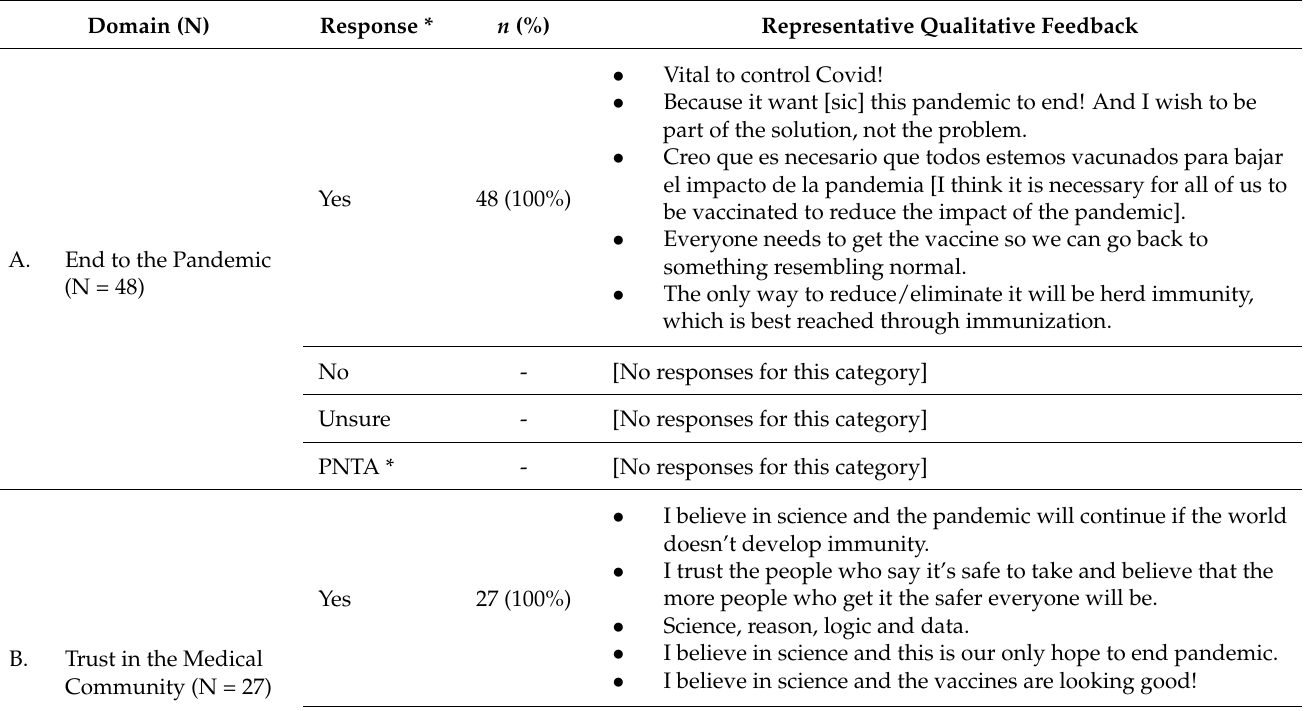
Table 2. Qualitative feedback for each domain stratified by response type: “yes”, “no”, “prefer not to answer”, or